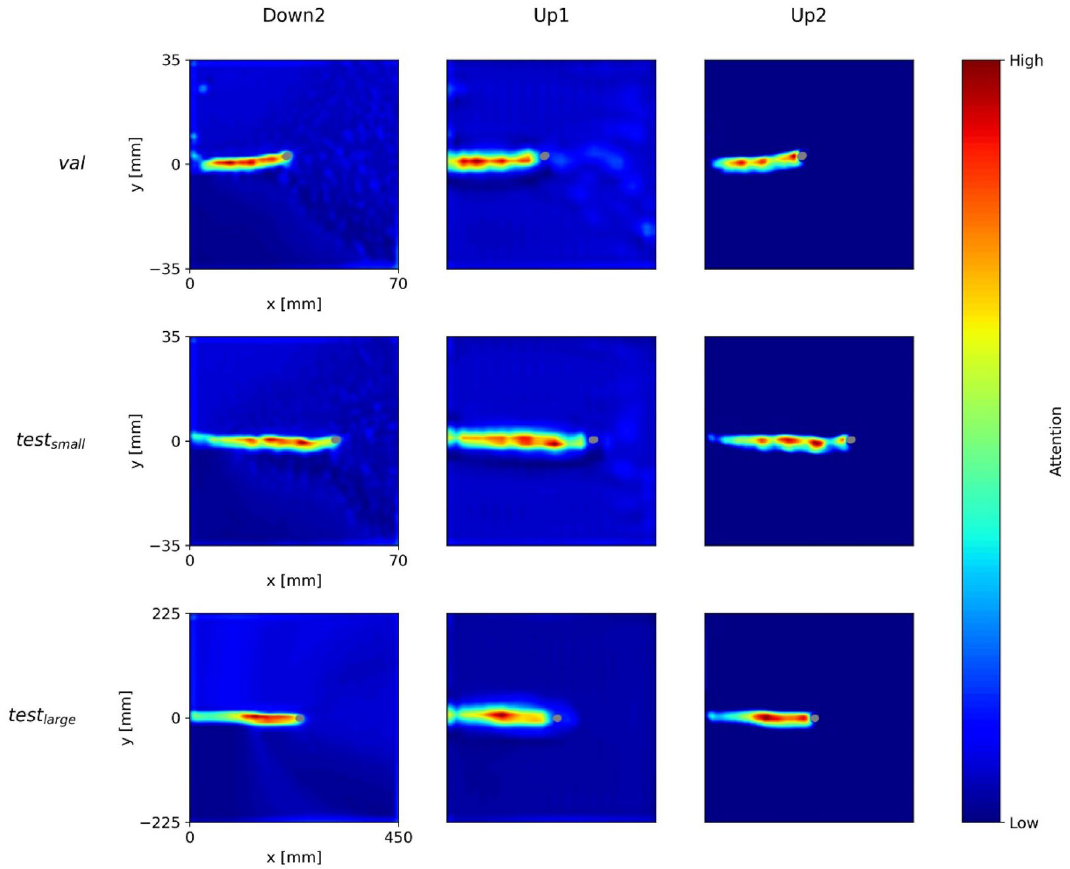
Figure 7. U-Net-2’s network attention of the layers Down2, Up1, and Up2 for the three DIC input samples